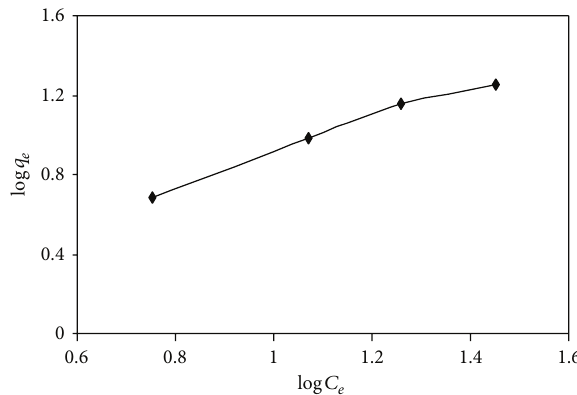
Figure 13: Freundlich isotherm of AB25 on IJSP at 35 ± 1 ∘ C. Con- ditions as in Figure 8.